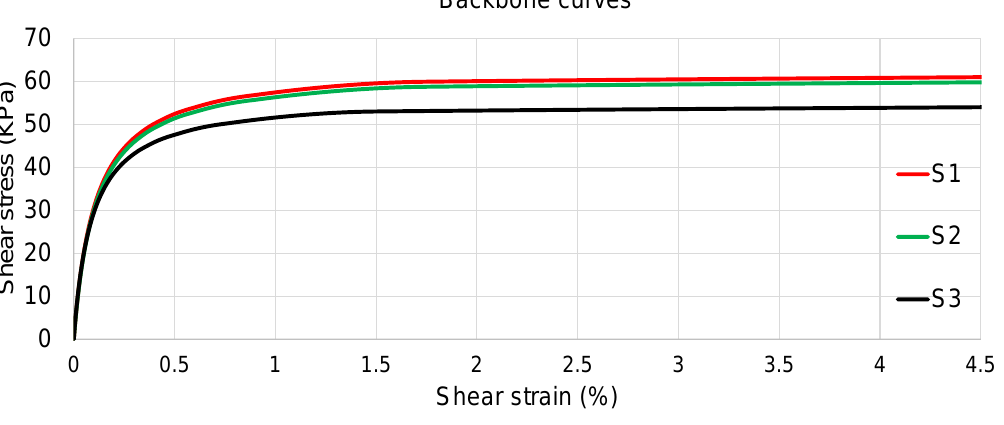
Figure 5. Soil C backbone curve. Table 3. Soils C characteristics.